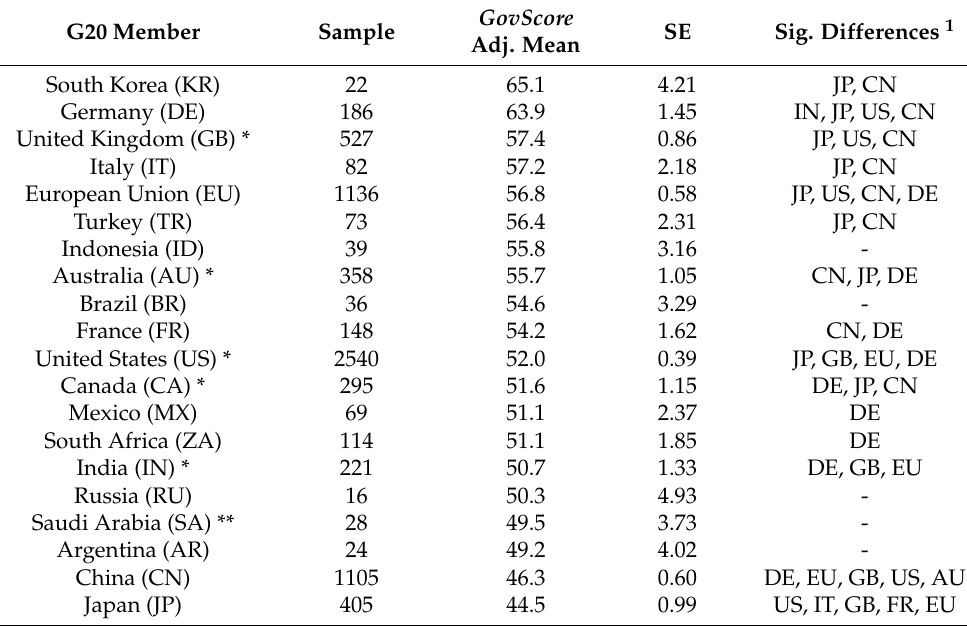
Table 1. The analysis of covariance of GovScore by country/group of countries, adjusted for company size, in descending